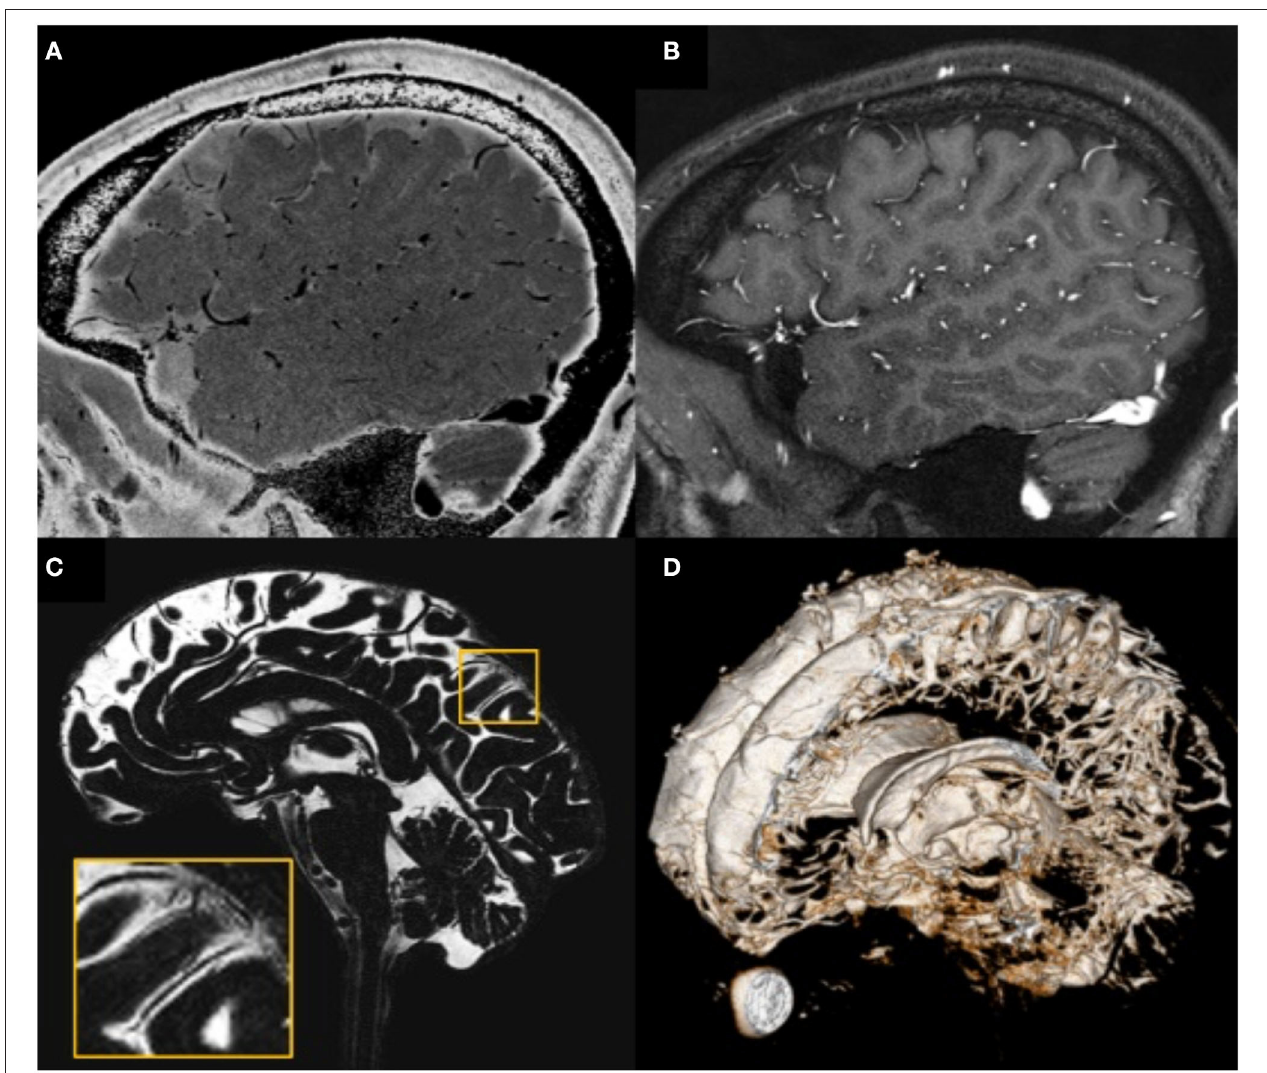
FIGURE 4 | Illustration showing that all MRI-visible vasculature were surrounded by CSF. (A) sT2W image with bright CSF and dark blood; (B) T1W with bright blood signal but dark CSF signal; (C) CSF-only images, acquired by T2-TSE sequence with TE = 345ms at 3T; (D) a 3D rendering of the CSF-only images. (A) and (B) were results from the high-resolution STAGE scans. The enlarged image in (C) shows several MRI-visible vasculature (dark curves) surrounded by bright CSF. Images were generated from the second experiment as described in the method section.